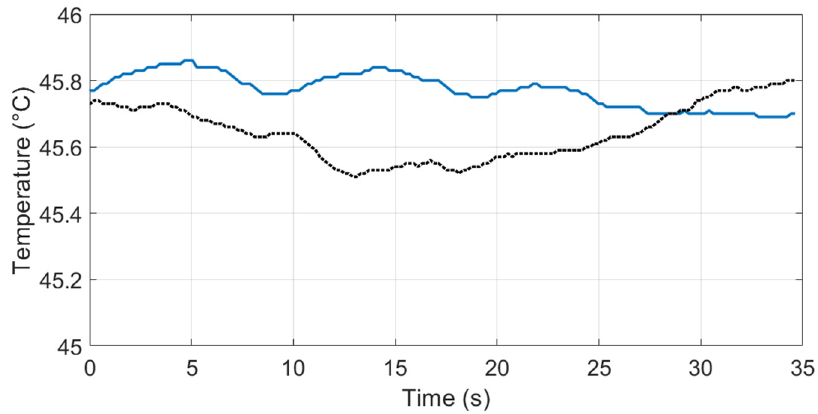
Figure 10. Temperature of conductors: Dotted line —three-phase AC transmission; Solid line — Switching conductors DC transmission.